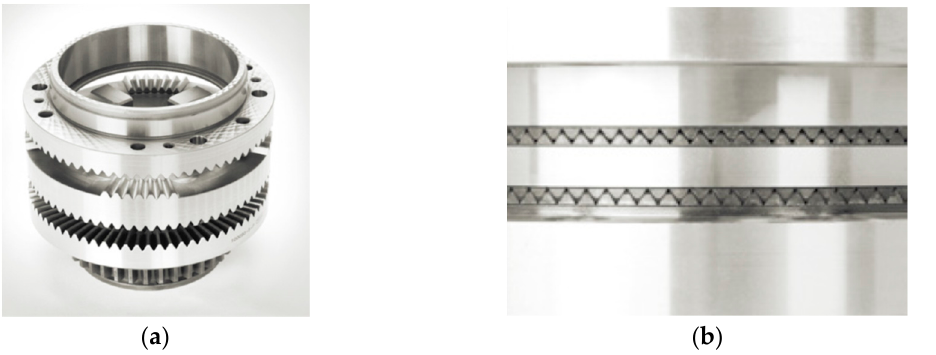
Figure 1. Example of Hirth rings: ( a ) disengaged and ( b ) engaged.